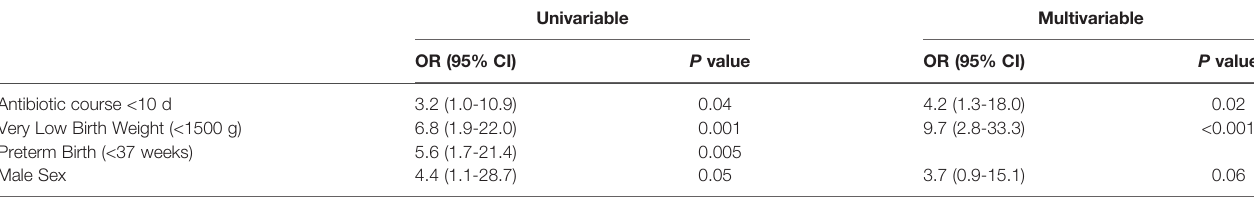
TABLE 3 | Univariable and Multivariable Logistic Regression analysis of recurrent GBS disease (UKROI).